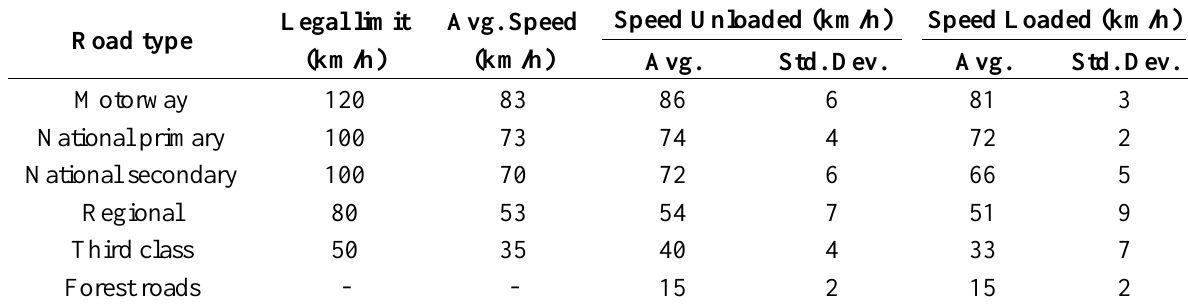
Table 4. Average speeds per road type travelling loaded and unloaded.